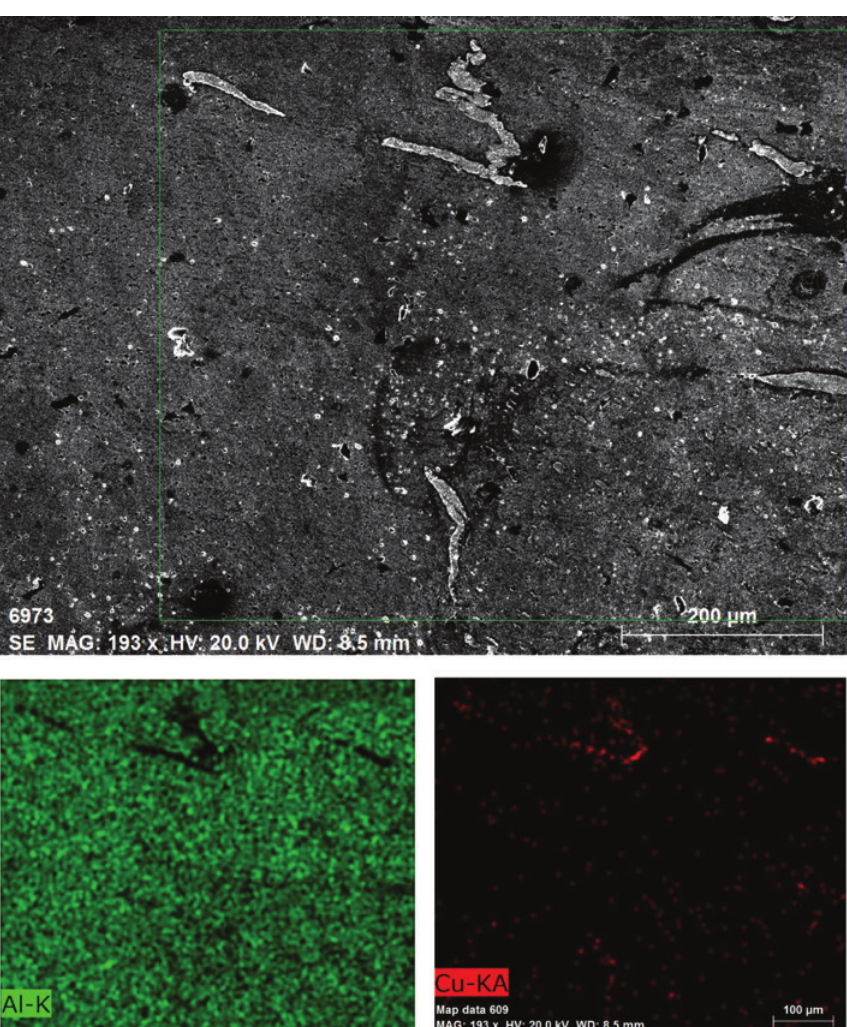
Figure 8: SEM backscattered electron image, the EDS, and the element mapping analysis on the advancing side of the stir